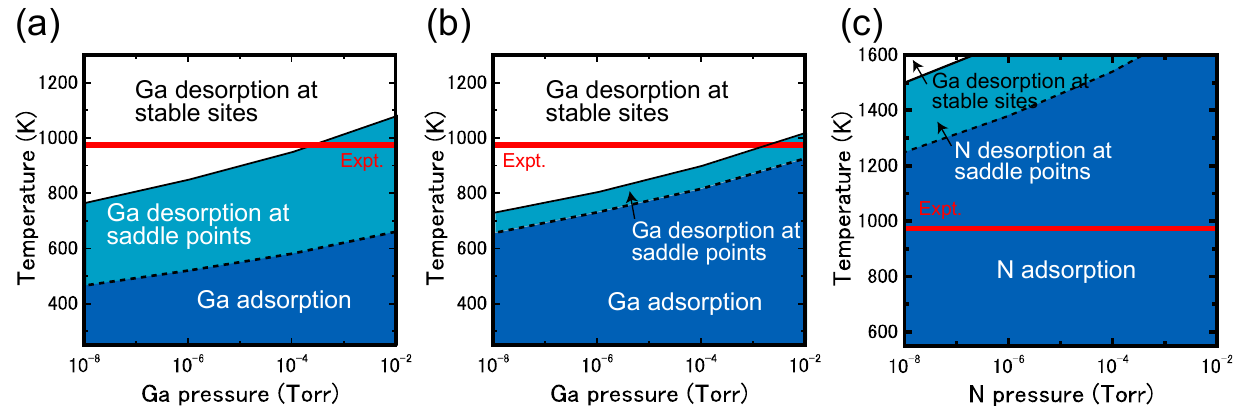
Figure 31. Calculated surface phase diagrams for Ga adsorption on ( a ) a GaN (cid:4666)112 (cid:3364) 2(cid:4667) surface with Ga adatom and ( b ) a GaN (cid:4666)112(cid:3364)2(cid:4667) surface with a Ga monolayer and ( c ) N adsorption on a GaN (cid:4666)112(cid:3364)2(cid:4667) surface with a Ga monolayer as a function of temperature and pressure. The adsorption phase boundary at the stable sites (saddle points) is represented by solid (dashed) lines. The growth temperature in Refence [91] (~1000 K) is denoted by a horizontal